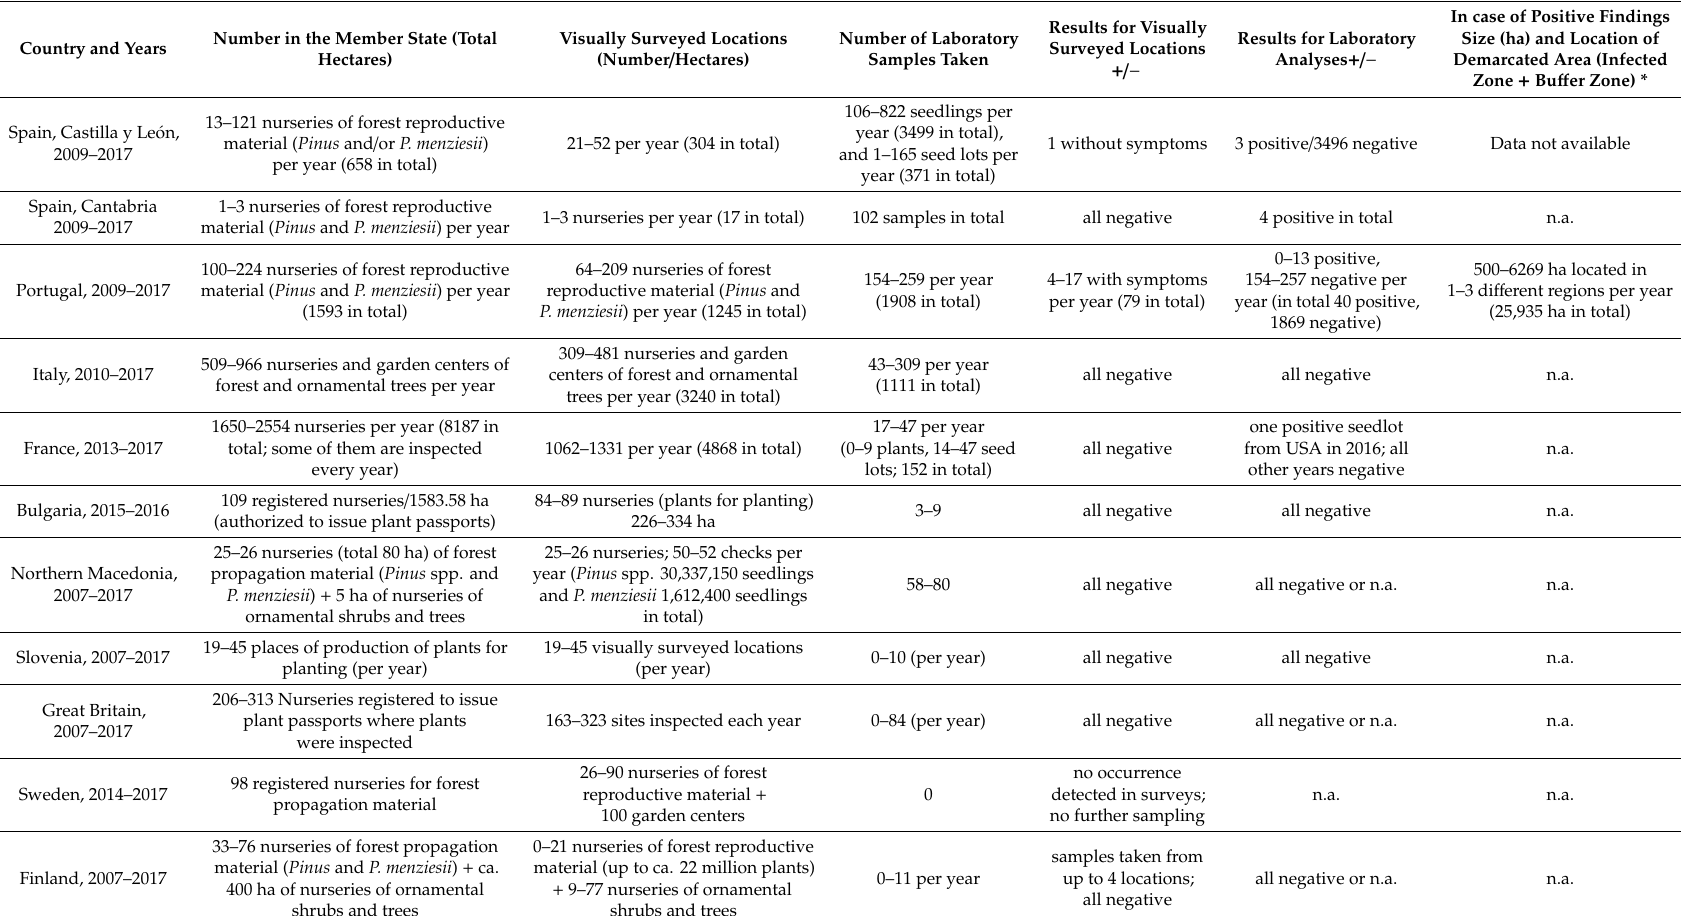
Table 1. Sampling approaches in production sites (nurseries) for planting material. The data is based on the annual reports submitted to the European Commission by the